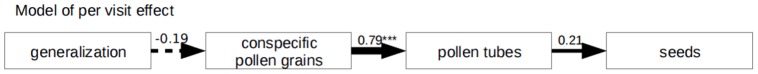
Causal model to evaluate per visit effect on Opuntia sulphurea.Arrows represent the causal effect of a variable on another; line width and the number above the arrows represent the magnitude of the pathway coefficient. Continuous lines indicate a positive effect; dashed lines indicate a negative effect. Statistical significance of pathway coefficients is indicated as follows: * = p<0.05; ** = p<0.01; *** = p<0.001. This causal model tests whether pollinator generalization determines the per-visit effect of a specific pollinator species on the focal plant.